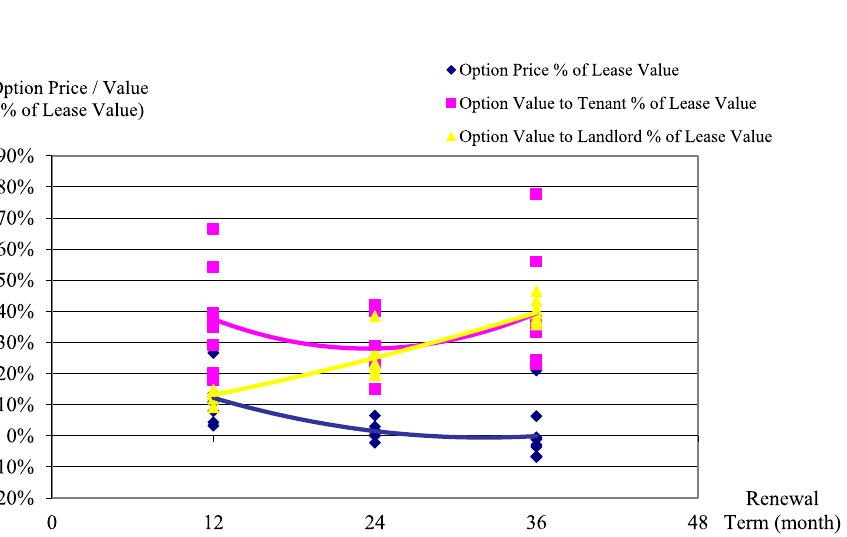
Fig. 3 Option value/price with original lease term